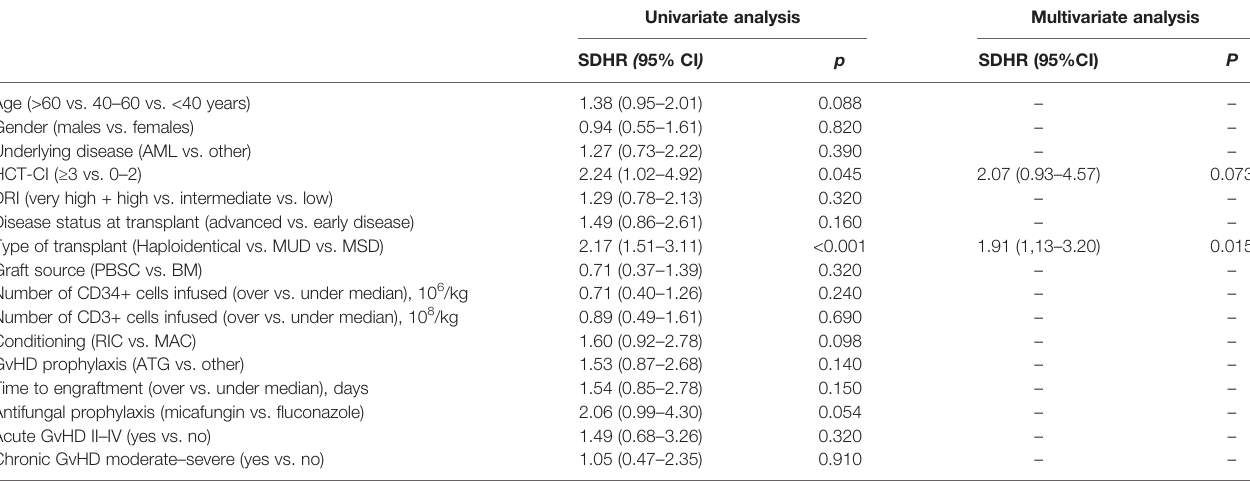
TABLE 3 | Univariate and multivariate analysis of risk factors for invasive fungal infections after allogeneic HSCT.